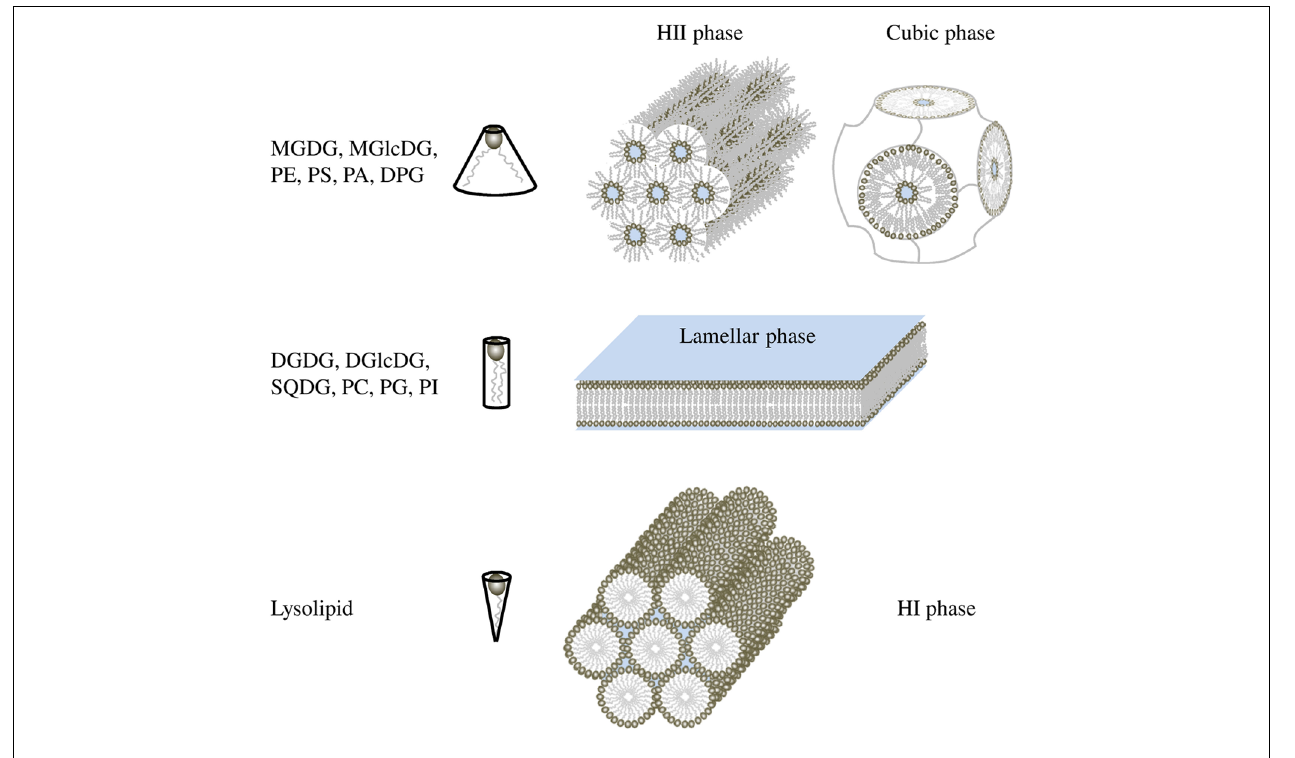
molecular shape similar to an inverted cone and induce a positive curvature strain in membranes.They favor the formation of tubular (HI) or spheric micelles. Lipids that have similar cross-sectional areas for the polar head and hydrophobic region look like cylinders.They form lamellar phases, with no curvature